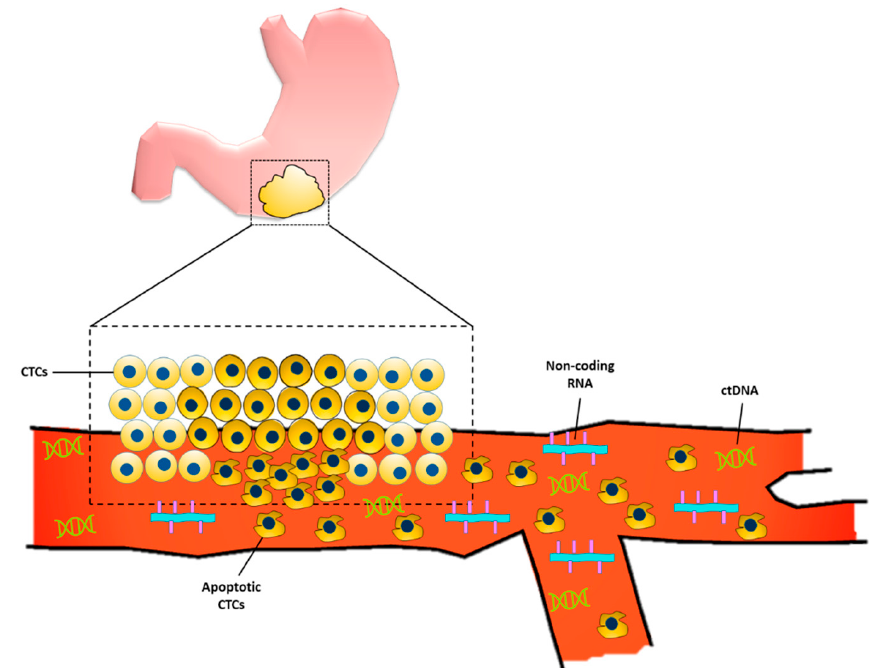
Figure 1. Liquid biopsy markers for gastric cancer. Primary gastric tumor sheds circulating tumor cells (CTCs) into the bloodstream. Some of the CTCs undergo apoptosis which allows for the release of the cell’s genetic material, including circulating tumor DNA (ctDNA) and non-coding RNAs..